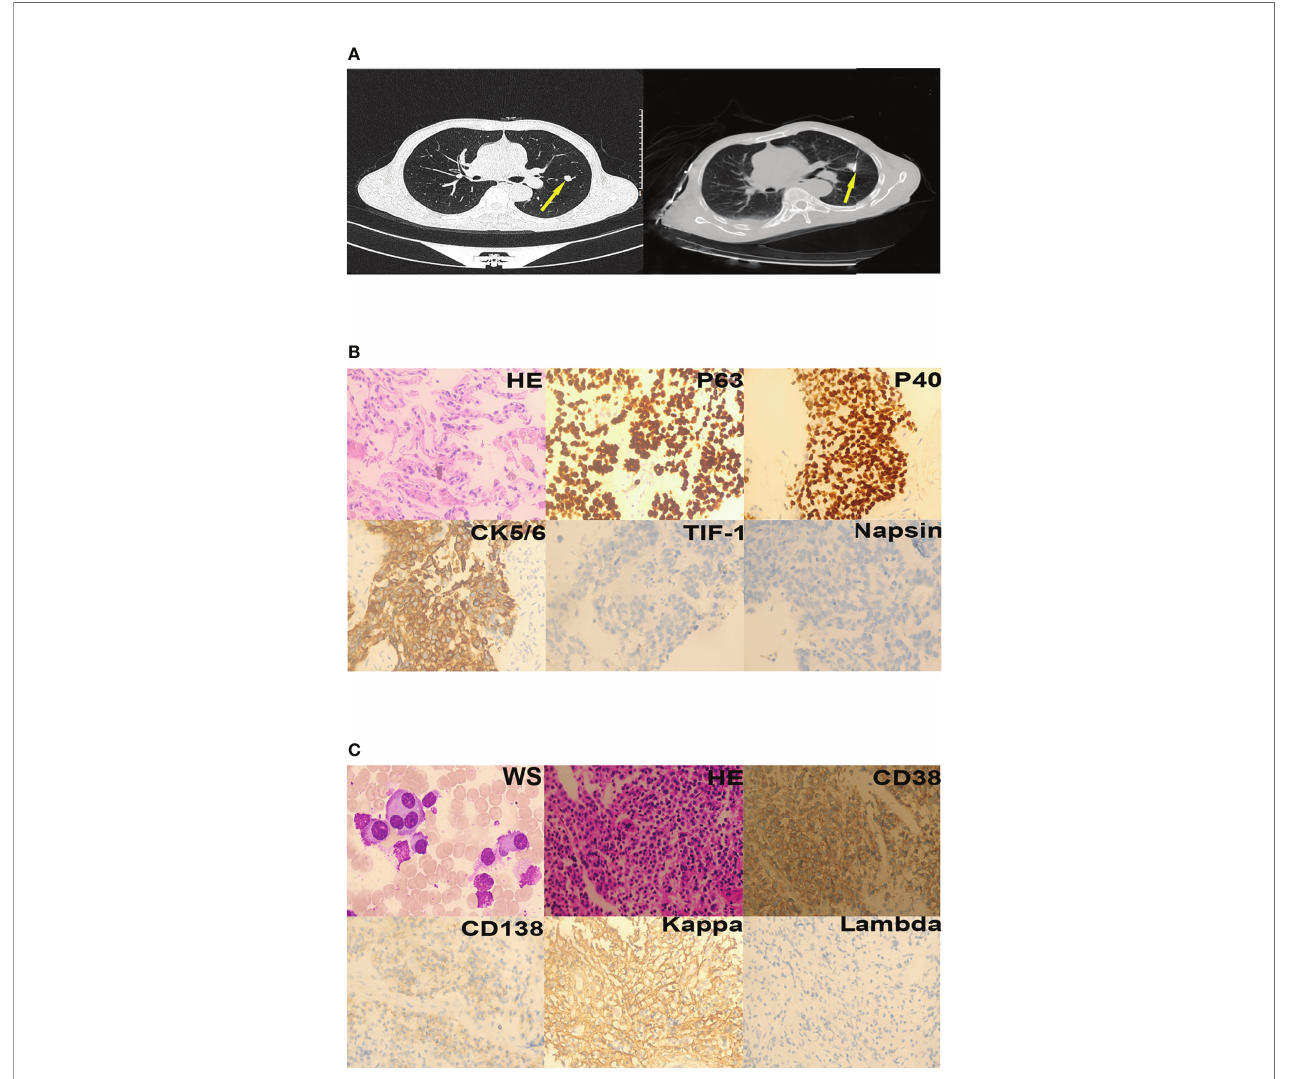
FIGURE 1 | Case 1. (A) Lung nodules (yellow arrows) on chest computed tomography; left - cross section, right - post-treatment by percutaneous microwave ablation. (B) Squamous cells could be seen in the nodules (hematoxylin-eosin staining, 400×). Immunohistochemistry revealed that the tumor was P63-positive, P40- positive, CK5/6-positive, TIF-1-negative, and Napsin-negative. (C) Plasma cells were seen in the bone marrow aspirate and biopsy specimens (Wright staining [WS], 1000×; hematoxylin-eosin staining, 200×). Immunohistochemistry revealed that the plasma cells were CD38-positive, CD138-partly positive, kappa-positive, and